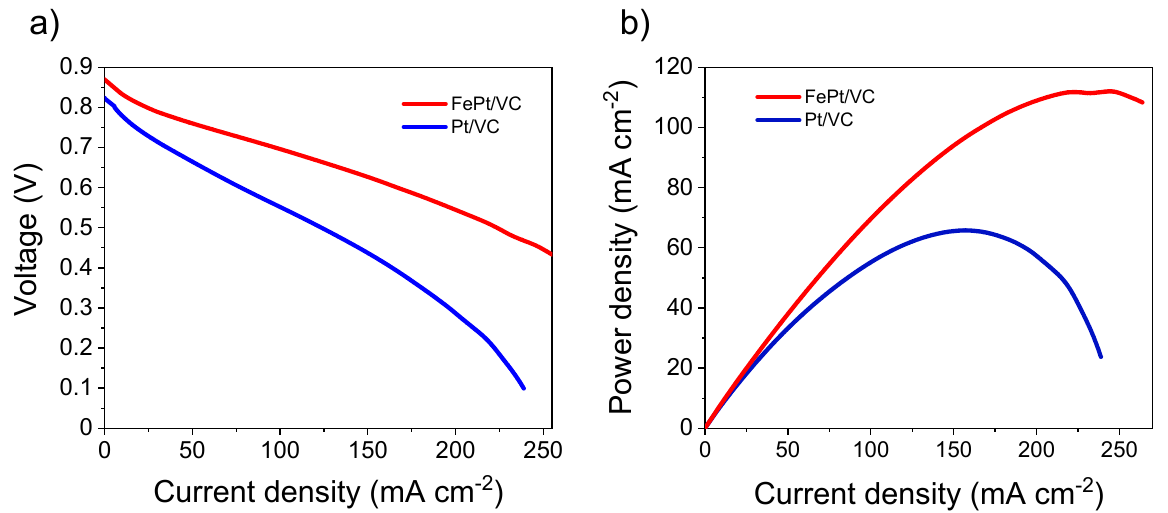
Figure 5. Performance of FePt/VC and Pt/VC in a self-breathing PEMFC, ( a ) current density vs. voltage, ( b ) current density vs. power density, catalyst loading at the active area of both the anode and cathode was the same, i.e., 0.8 mg cm − 2 . The H 2 flow rate was 10 mL min − 1 . Catalyst loading was the same at both MEAs (0.8 mg cm − 2 ) and the self-breathing PEMFC operation was done at an ambient condition (25 °C, H 2 at 1 bar and 20%RH at the anode).